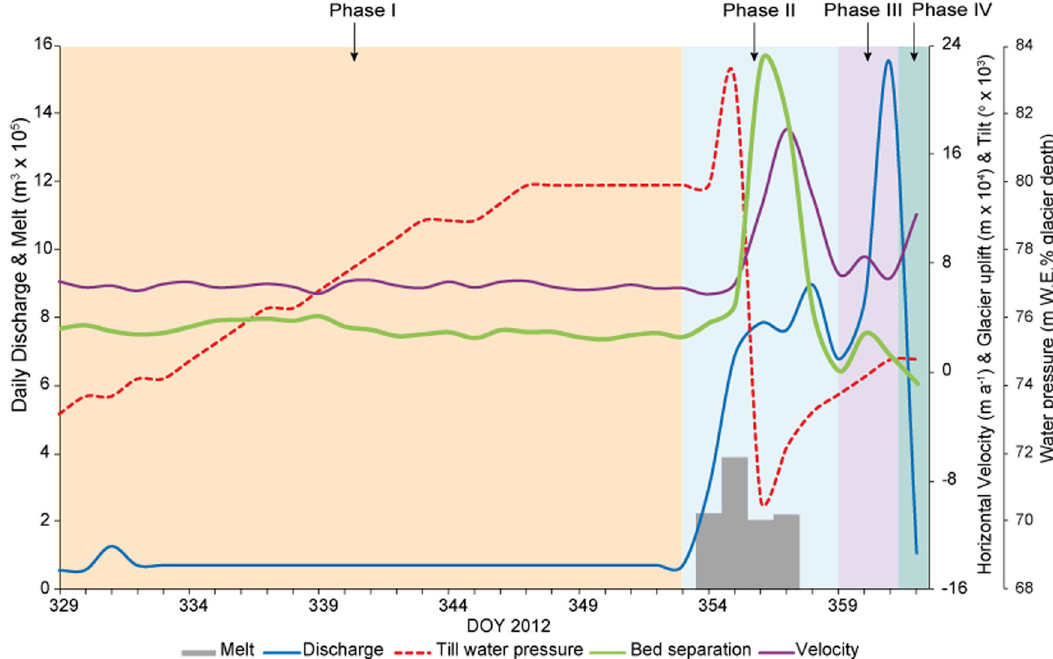
Fig. 4 Detail of winter cycle 3 (2012). This data is from the Sultartungnajökull catchment with the different phases shown (see Fig. 2b for reference). An estimated till water pressure record, reconstructed from 2009/10 warm events, is shown for